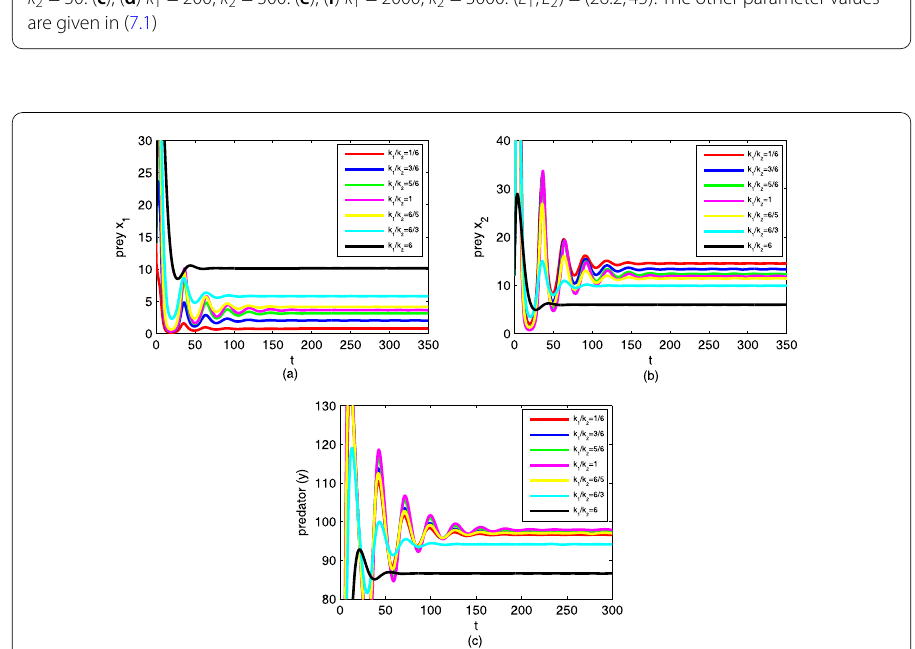
Figure 2 Phase portrait and time graph of model (2.1) around the interior equilibrium point. ( a ), ( b ) k 1 = 20, k